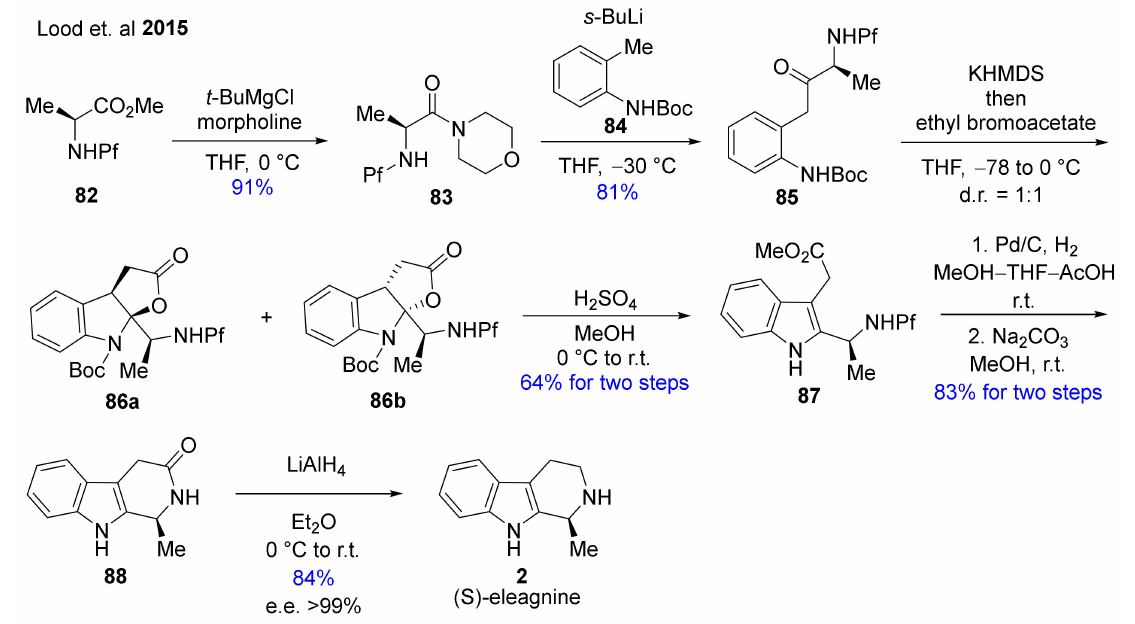
Scheme 2. Enantioselective synthesis of ( S )-eleagnine ( 2